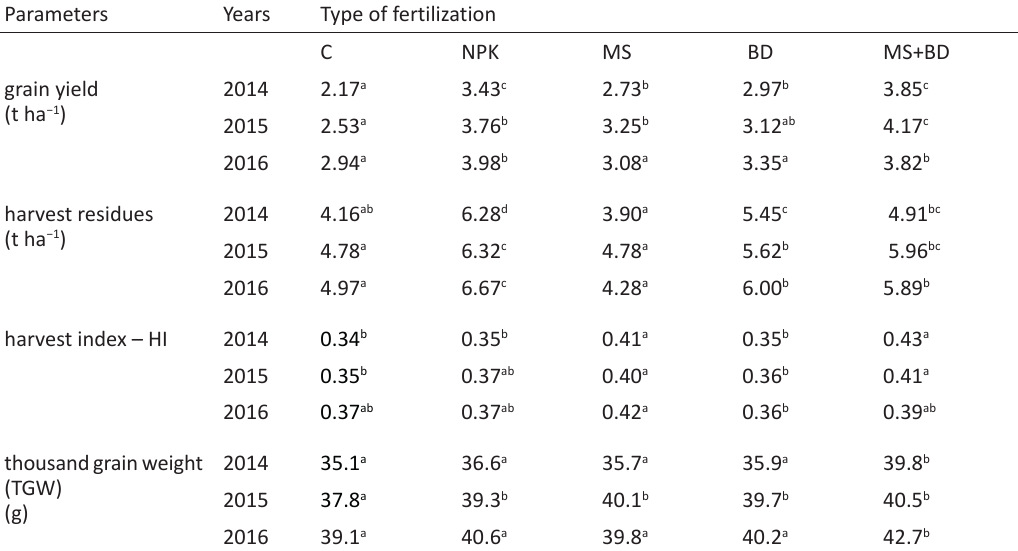
Table 3. Effect of biogas digestate (BD) and mining waste (mudstones – MS) on the yield of winter wheat (mean, n = 3)